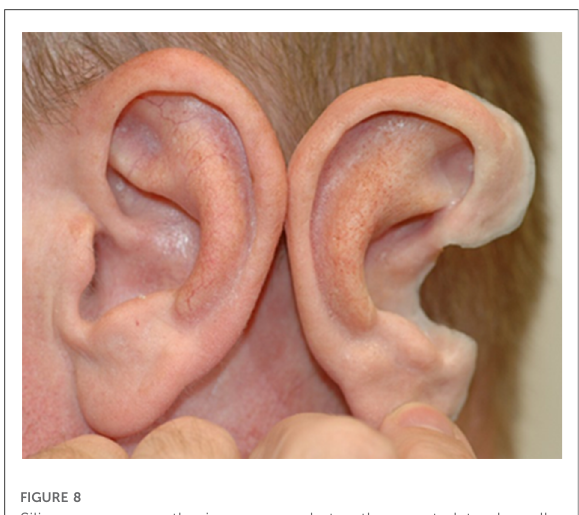
FIGURE 8 Silicone ear prosthesis compared to the contralateral well- developed